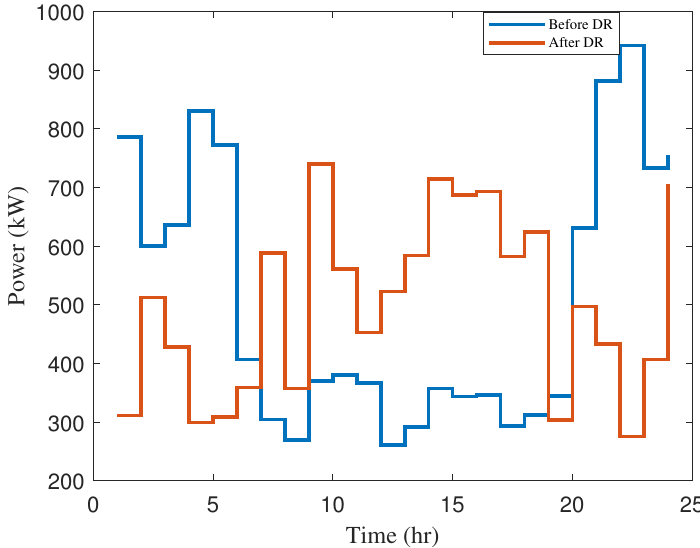
Figure 8. Demand − response schedule with actual PV and wind data.